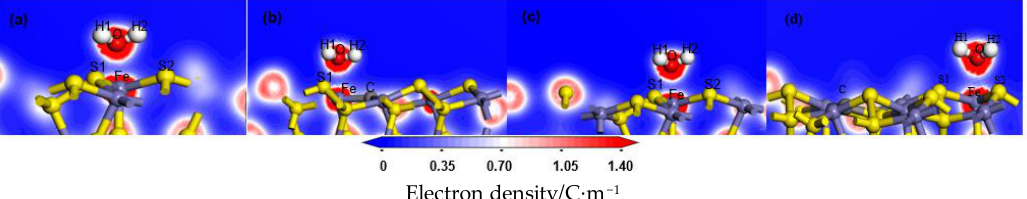
Figure 4. Electron density after H 2 O adsorption on the coal pyrite surfaces: ( a ) ideal surface; ( b ) doping-position; (c ) ortho-position; ( d ) meta-position.